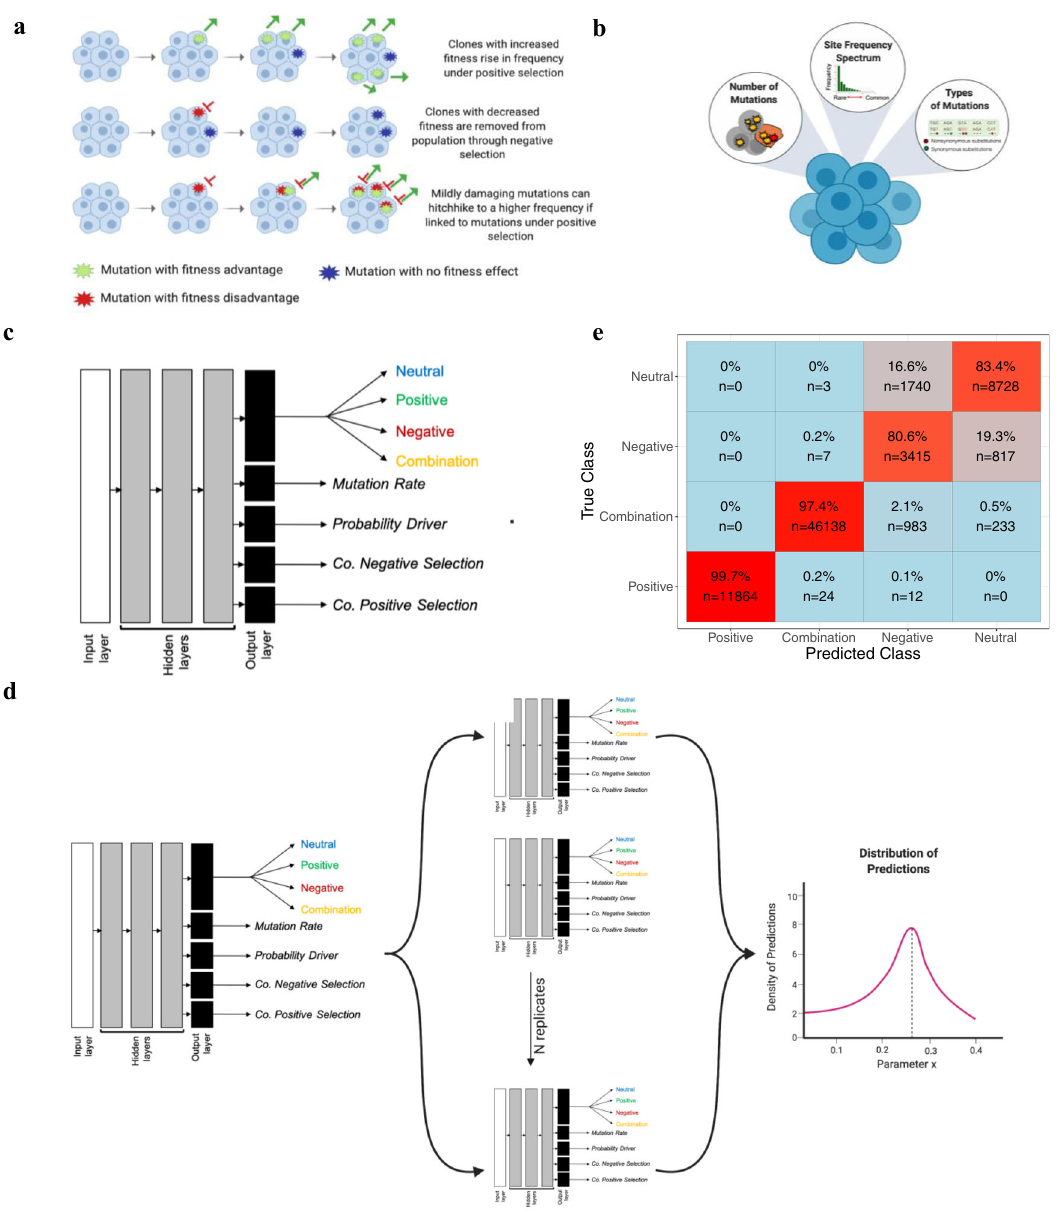
Fig. 1 Deep learning models can be used to discriminate amongst the evolutionary pressures shaping blood evolution. a The impact of selection and genetic drift on shaping clonal dynamics. Cells accumulate somatic mutations in each division. The majority of mutations will be either neutral (blue) or mildly damaging (red). Driver mutations will increase the fi tness of a cell and increase the frequency in the population (green). However, mutations are also able to rise in frequency through genetic drift. b Mutation summary statistics extracted from blood cell populations. Summary statistics fall into three categories: (1) Counts of mutations in each blood sample (overall and strati fi ed according to mutation type (silent and missense) across variant allele frequency intervals, (2) The frequency of mutations (variant allele frequency), and (3) mutation annotation and respective ratios (proportion of missense relative to total missense sites over the proportion of silent mutation relative to total silent sites). A total of 16 summary statistics are extracted from each population. c Deep Neural Network Architecture. Each DNN was trained as a multi-task neural network and classi fi es a population into one of four overarching evolutionary classes and predicts four continuous parameters. Each neural network consisted of an input layer (16 units with each unit corresponding to a summary statistic), three hidden layers (512 units), and fi ve output layers which included the classi fi cation output (four units) and four regression outputs (one unit each). d DNN Ensemble. We trained a total of ten deep neural networks (DNNs) independently, yet with identical architecture. Through employing an ensemble-based approach, we are able to obtain a distribution of predictions for each population. e Classi fi cation performance for simulated evolutionary classes. The y -axis represents the true evolutionary class, and the x -axis represents the predicted evolutionary class. Classi fi cation accuracy ranges from blue (low accuracy) to red (high accuracy). We obtain a high classi fi cation accuracy across evolutionary classes (94.8%). Positive and combination classes are predicted with 99.7% and 97.4%, respectively. We observe a reduction in accuracy in neutral (80.6%) and negative (83.4%) classes of